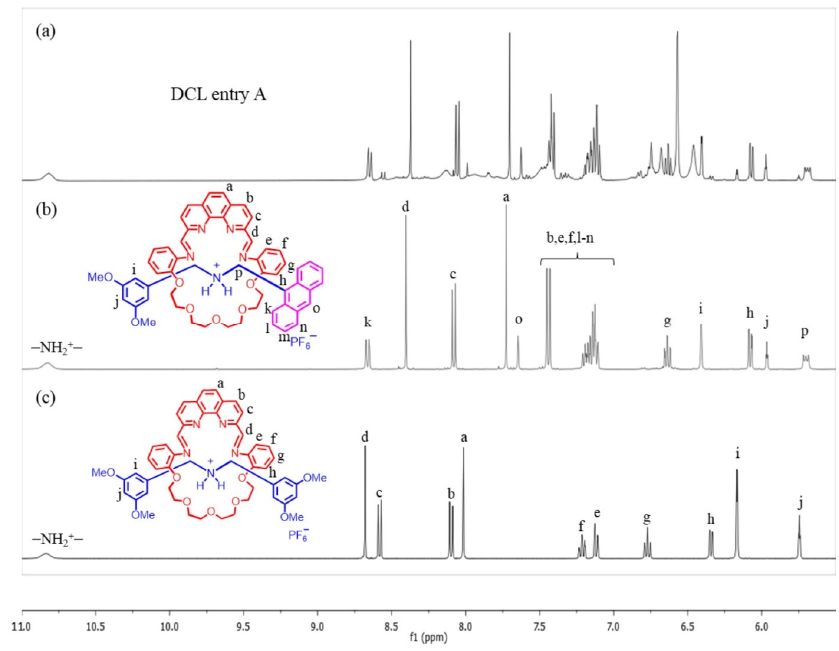
Figure 1. Partial, stacked 1 H NMR spectra (CD 3 CN, 400 MHz, 298 K) of ( a ) dynamic combinatorial library (DCL) entry A; ( b ) 8 -H · PF 6 ; and ( c ) 12 -H · PF 6